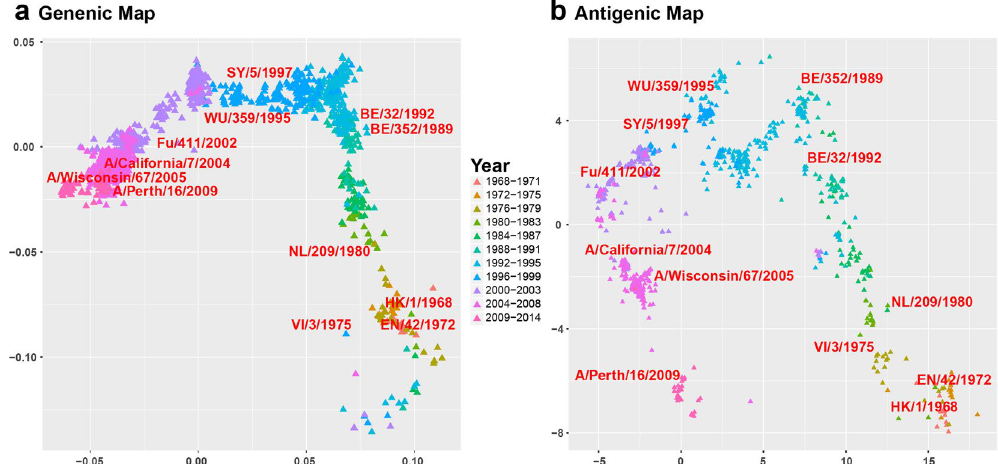
Figure 3. The genetic ( a ) and antigenic map ( b ) for all 1968 non-redundant H3N2 HA1 protein sequences between 1968 and 2014. The viruses are colored by their year of discovery.